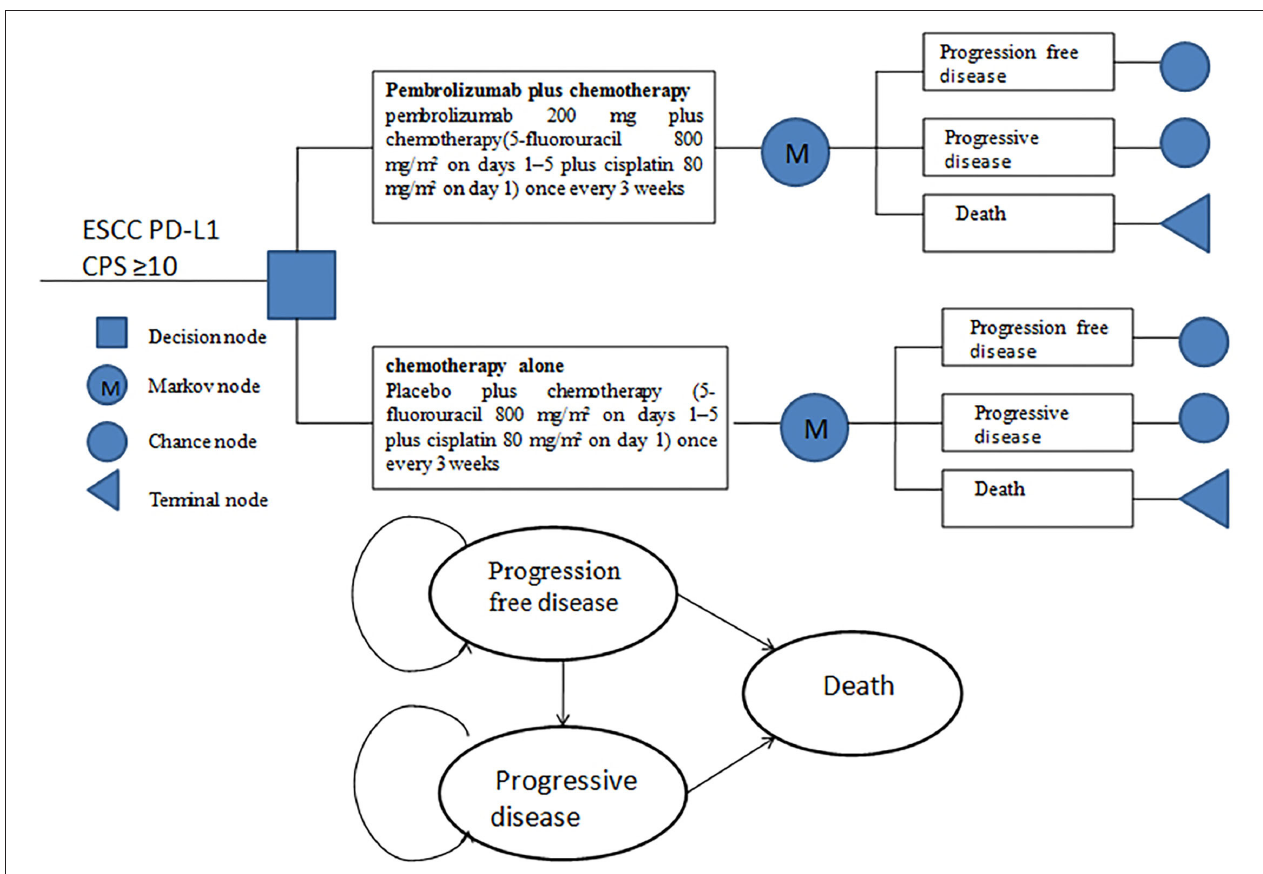
FIGURE 1 | Model structure simulated three health states: progression-free disease, progressive disease, and